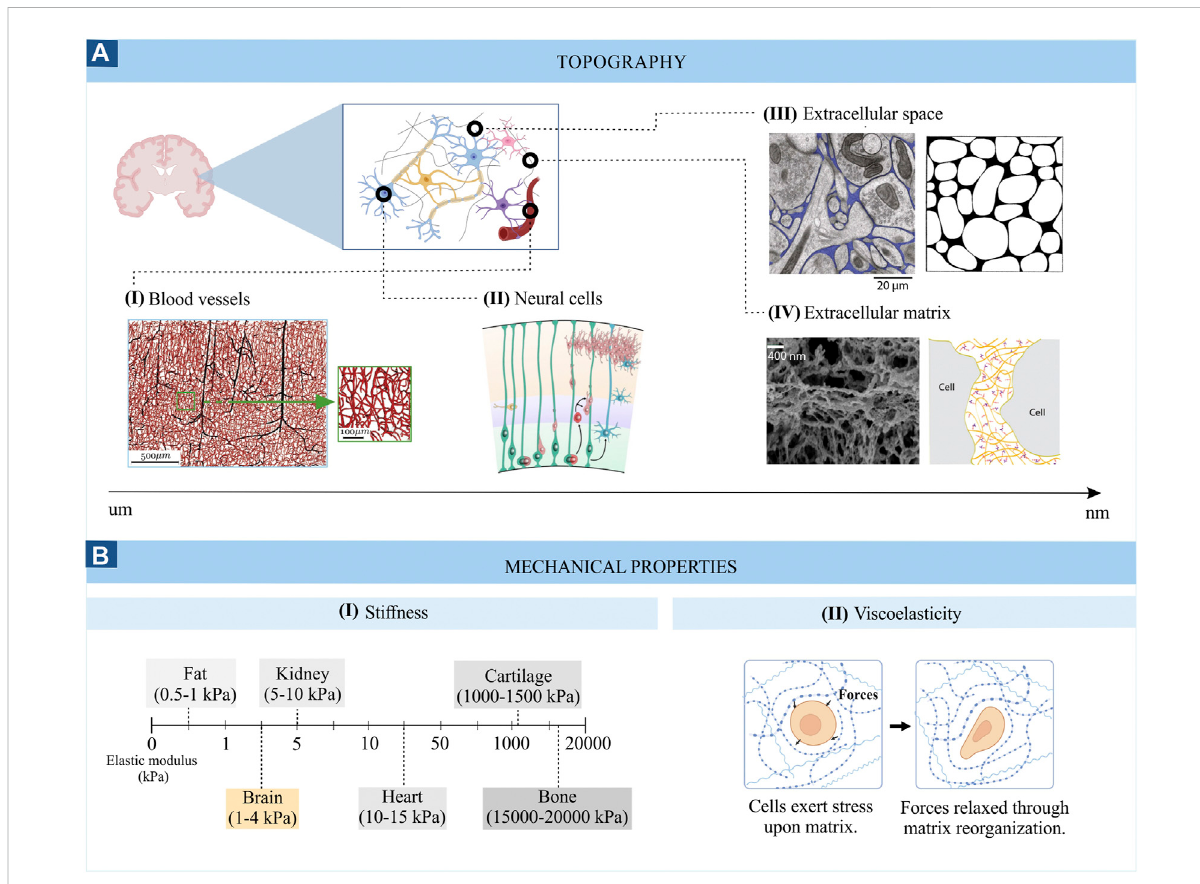
FIGURE 1 Topography (A) and mechanical properties (B) of brain tissue. Images from panel A are adapted from (I) Microvascular networks in the human brain (Peyrounette et al, 2018), (II) Schematic representation of the developing cortical plate (Barry et al, 2014), (III) Electron micrograph of mouse cerebral cortex where the extracellular space is coloured in blue (left) ((Korogod et al, 2015) and computer generated con fi gurations of the brain extracellular space (right) (Chen and Nicholson, 2000); (IV) Scanning electron micrograph of the brain ECM (left) (Tajerian et al, 2018) and schematic representation of the ECM (right) (Odackal et al, 2017). (B) represents the stiffness range (I) and viscoelasticity (II) of brain